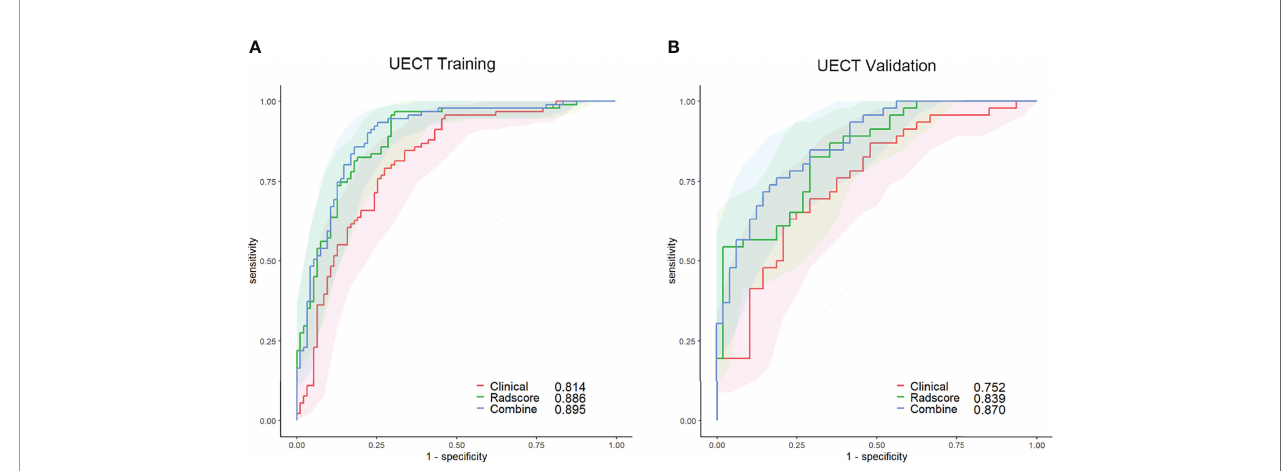
FIGURE 2 | ROC curves of the clinical (red lines), radscore (green lines), and combined (blue lines) models in the training set (A) and validation set (B) of the UECT model. The shaded areas represent the con fi dence intervals of the ROC curves. UECT, unenhanced computed tomography; ROC, receiver operating